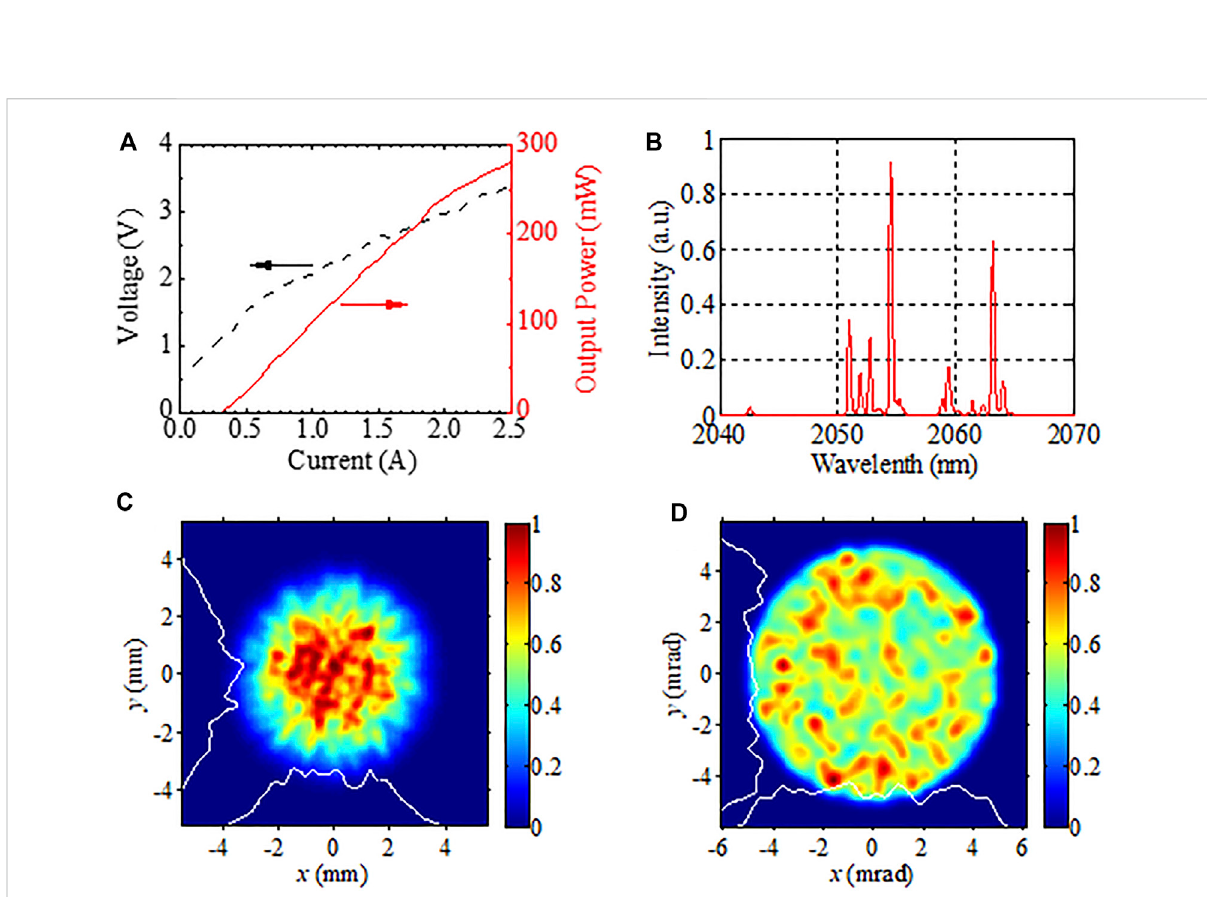
FIGURE 2 Laser output performance of antimonide fi ber-coupled semiconductor laser module: (A) PIV curve, (B) laser spectrum, (C) near- fi eld pattern and (D) far- fi eld pattern of output beam. The near- fi eld distribution is Gaussian and the far- fi eld distribution is fl